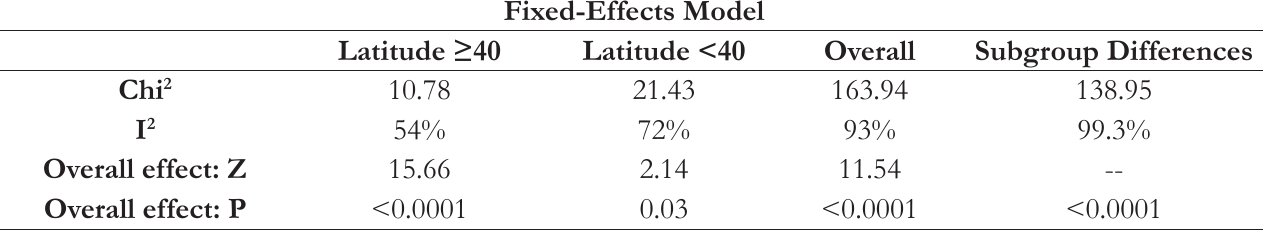
Table 2. Fixed-effects